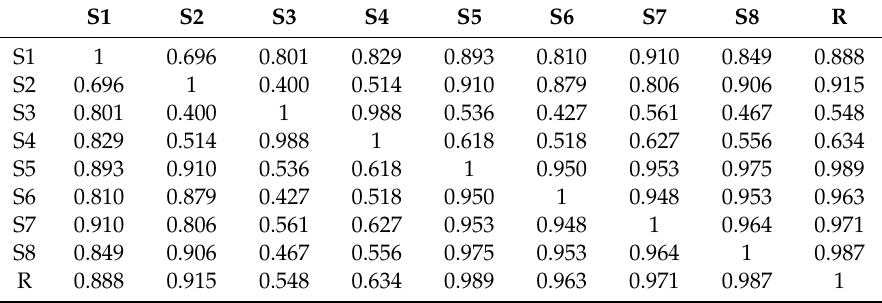
Table 3. Results of similarity analyzes of the HPLC fingerprint of